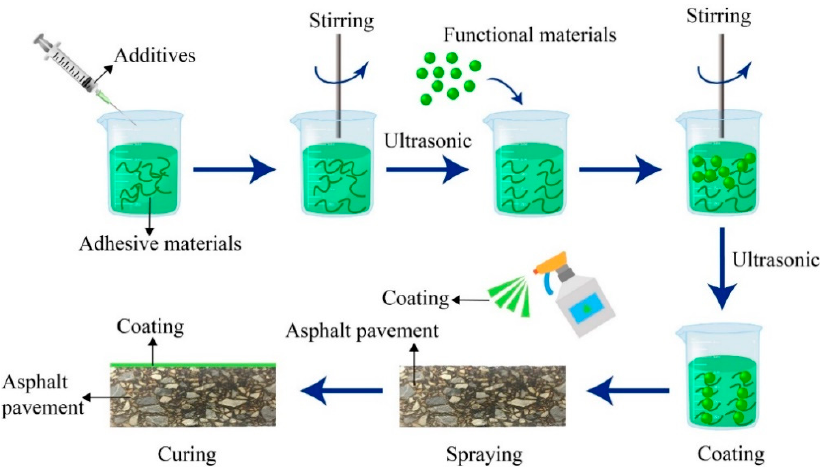
Figure 3. A schematic diagram of the coatings’ preparation process.